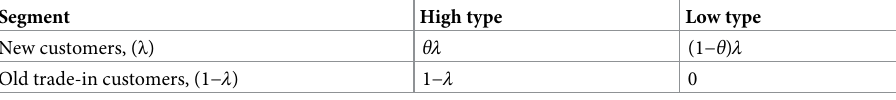
Table 3. A summary of the distribution of consumer types among the population.